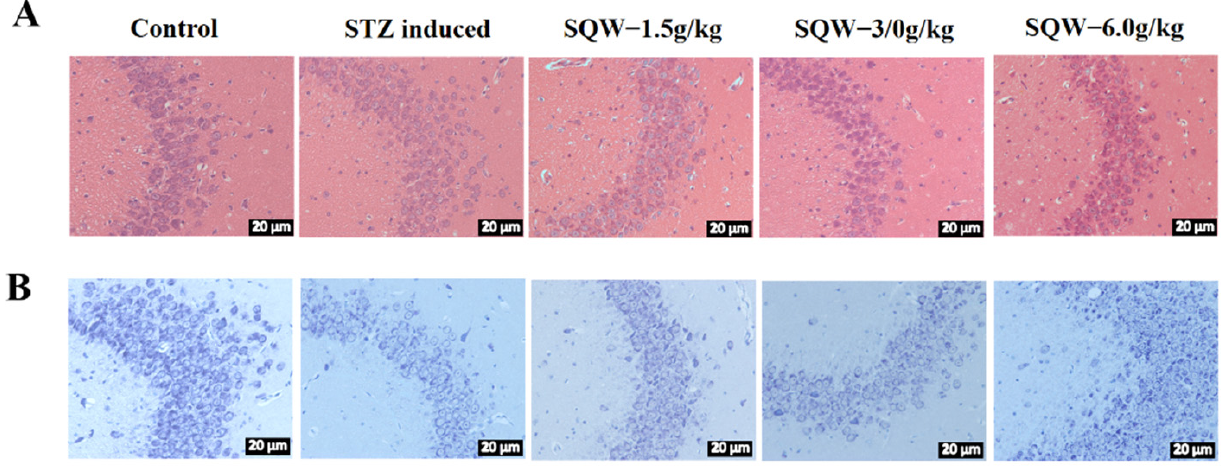
Figure 3. SQW alleviates the pathological damage of the hippocampus induced by STZ in rats. ( A ) The effect of SQW on the neuronal morphology of the hippocampal CA3 region induced by